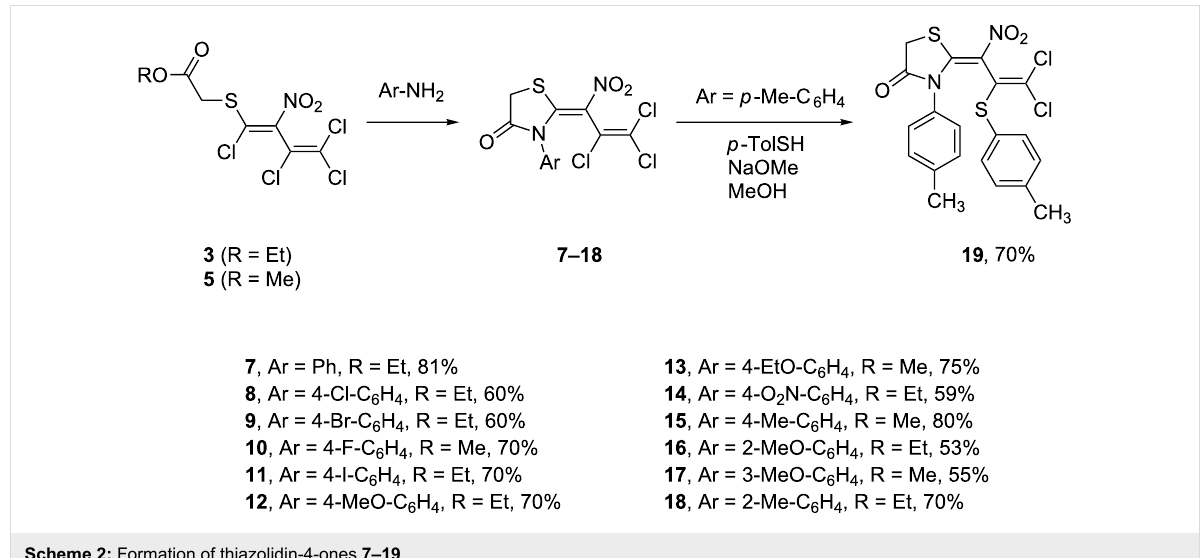
case of the ortho - or meta -substituted anilines 16 – 18 two atrop- isomers were generated. This phenomenon is due to a less hindered rotation of the C–N bond of the former anilines (Figure 1).